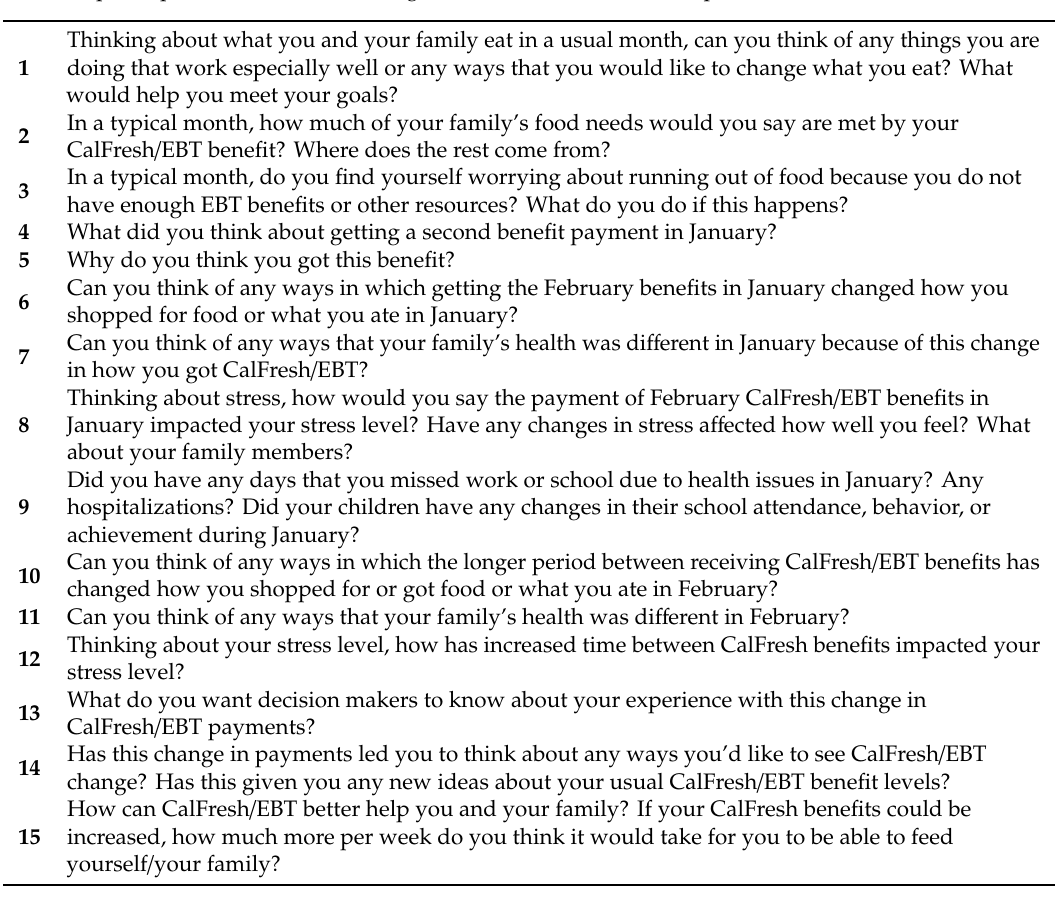
Table 2. Focus Group Semi-Structured Interview Guide. Questions asked during focus groups with SNAP participants in California during the 2019 SNAP benefit